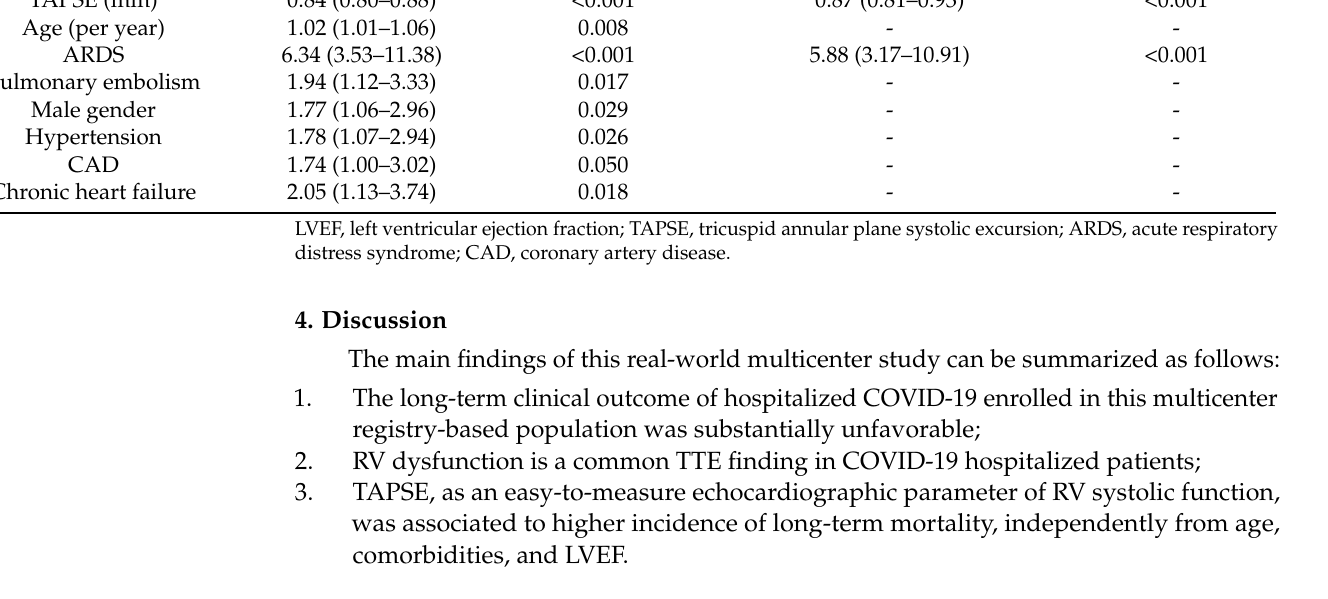
Table 3. Univariable and multivariable analysis for of the risk of 1-year mortality.